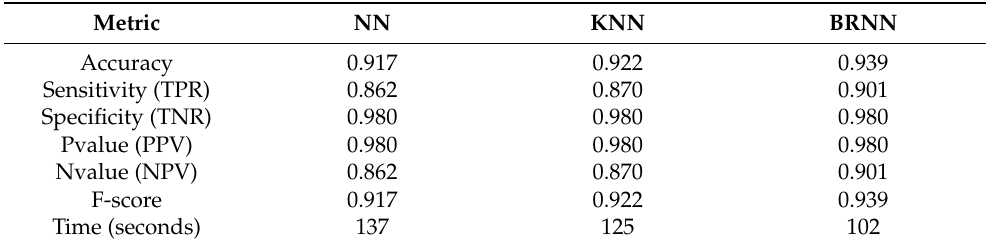
Table 5. Performance evaluation of the machine learning models applied to the first dataset